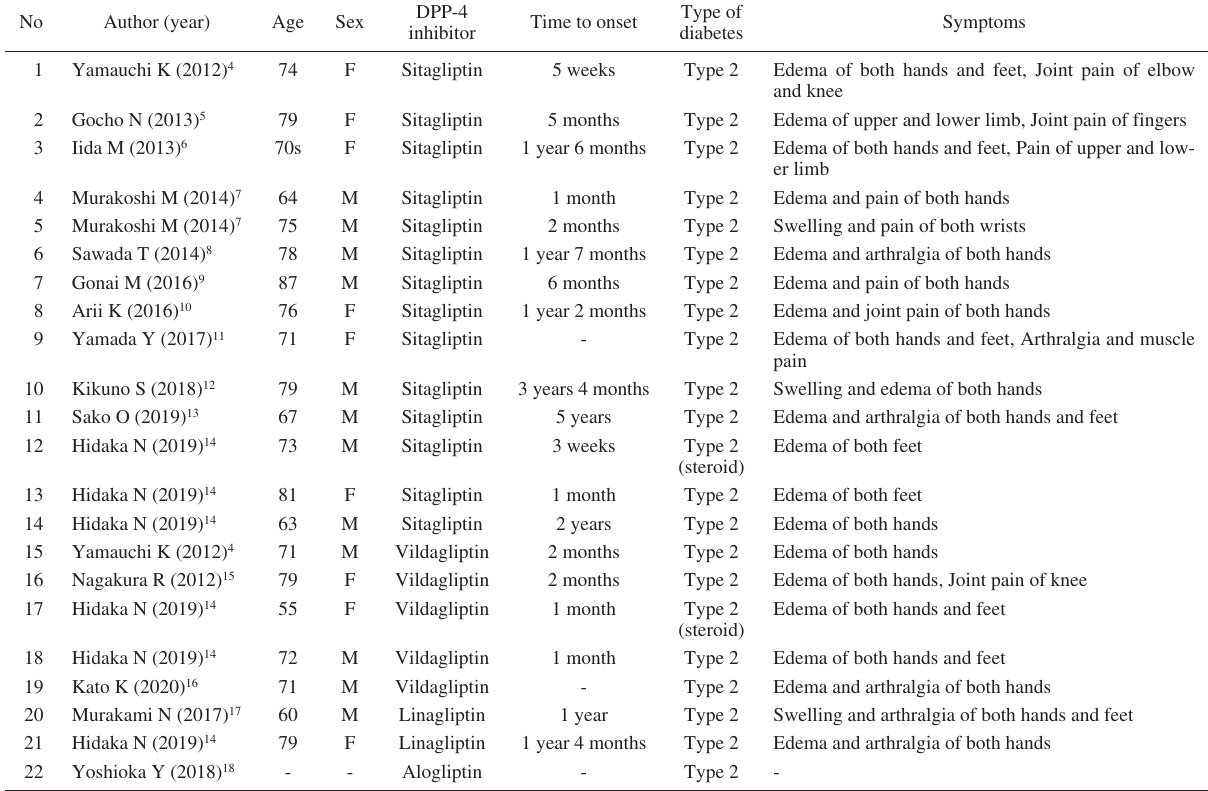
Table 2. Twenty two case reports of RS3PE syndrome involving DPP inhibitors in